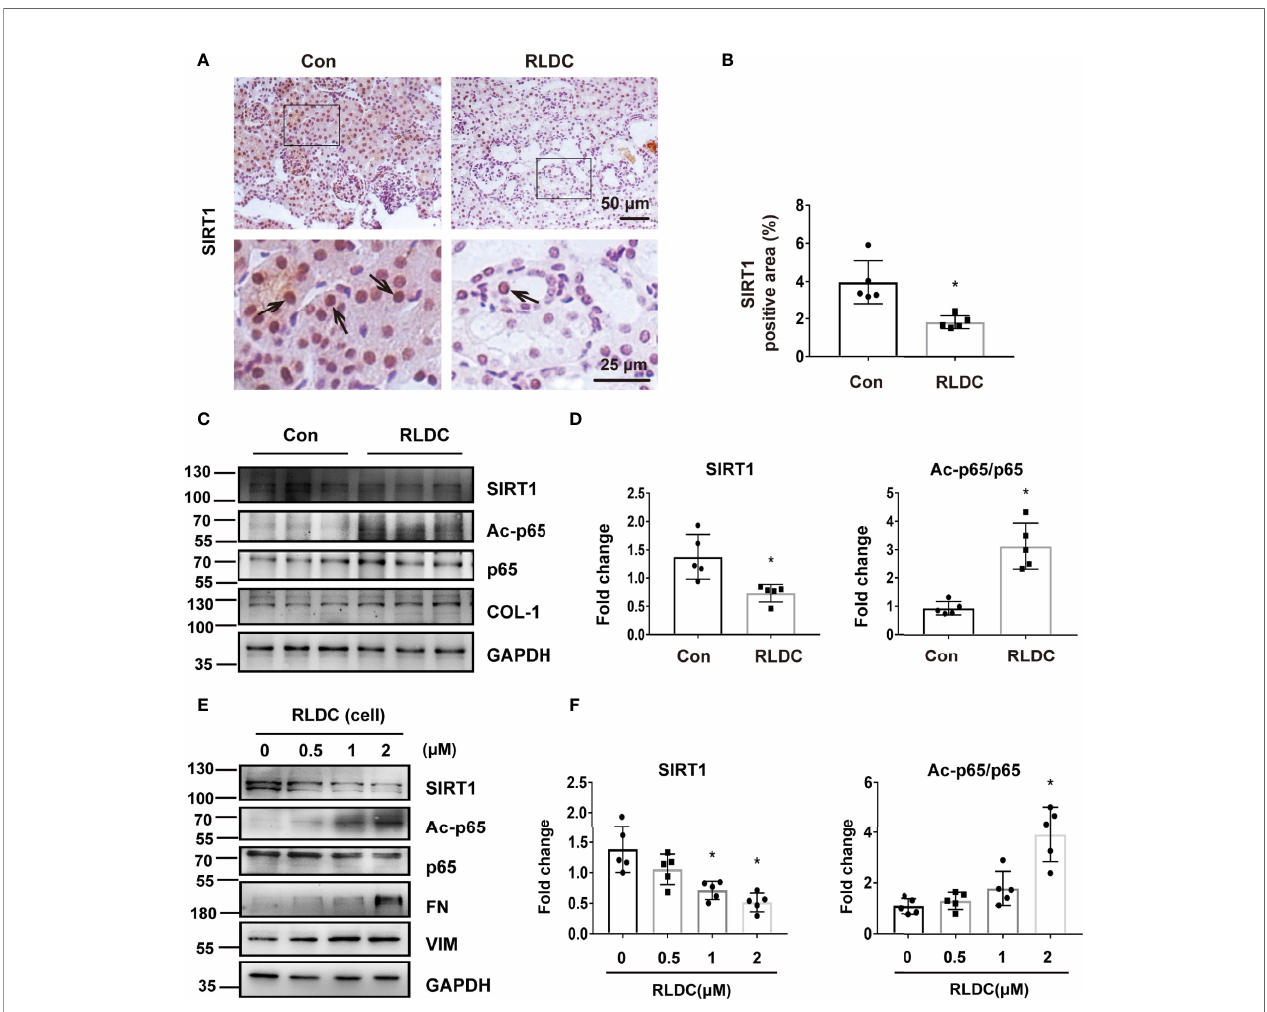
FIGURE 3 | RLDC induces down-regulation of SIRT1 and consequent acetylation of p65. (A – D) Male C57BL/6 mice were injected weekly with 8 mg/kg cisplatin for 4 weeks to collect samples 1 month later. (A) Representative images of immunohistochemical staining of SIRT1 in mouse kidneys. (n=5). The arrows in the magni fi ed images indicate positive staining. (B) Percentage of SIRT1 positive nuclei. (C) Representative immunoblots of SIRT1, Ac-p65, p65, COL-1 and GAPDH of total protein extracted from mouse kidney (n=5). GAPDH was used as a loading control. (D) Densitometry of SIRT1, Ac-p65, p65. (E, F) BUMPT cells were incubated with 2 m M cisplatin for 7h each day for 4 days, and collected at day 5. (E) Representative immunoblots of SIRT1, Ac-p65, p65, FN, VIM and GAPDH of total protein extracted from BUMPT cells (n=5). GAPDH was used as a loading control. (F) Densitometry of SIRT1 and Ac-p65. The protein level of control group was arbitrarily set as 1, and signals of other conditions were normalized with the control group to indicate their protein fold changes. Data are expressed as mean ± SEM. * P <0.05 vs . the control group (Con or 0 m